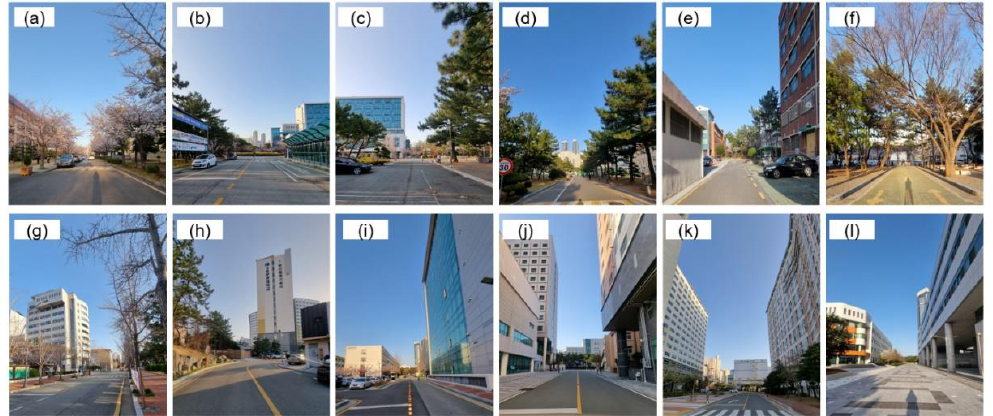
Figure 7. Photographs of scenery around the 12 survey points captured at approximately 17:00. Case A: survey points surrounded by only roadside trees ( a ) A1; ( b ) A2; ( c ) A3; ( d ) A4; Case B: survey points surrounded by buildings and trees ( e ) B1; ( f ) B2; ( g ) B3; ( h ) B4; Case C: survey points surrounded by only buildings ( i ) C1; ( j ) C2; ( k ) C3; ( l ) C4.